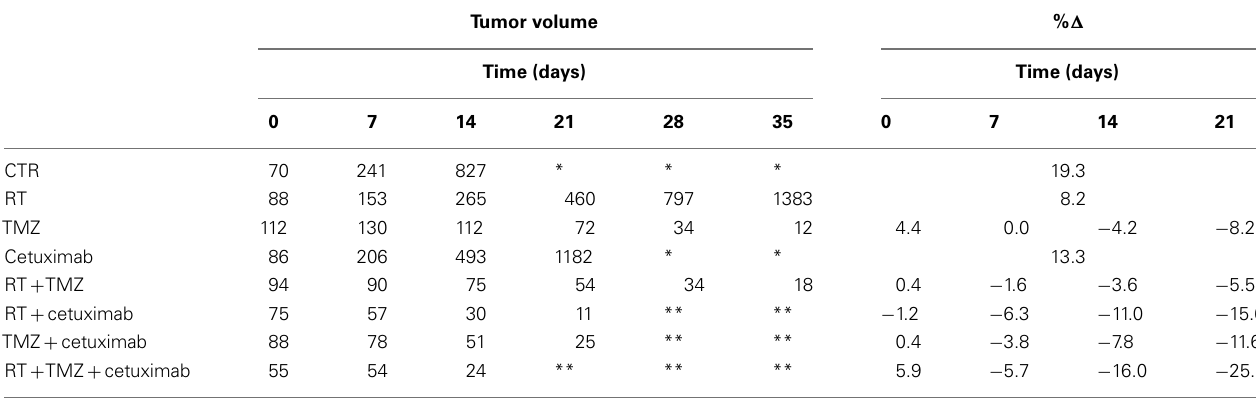
Table 2 | Estimates of the geometric mean tumor volume (in mm 3 ) over time and tumor growth rate, by treatment group, for the EGFRvIII U87 glioblastoma cell